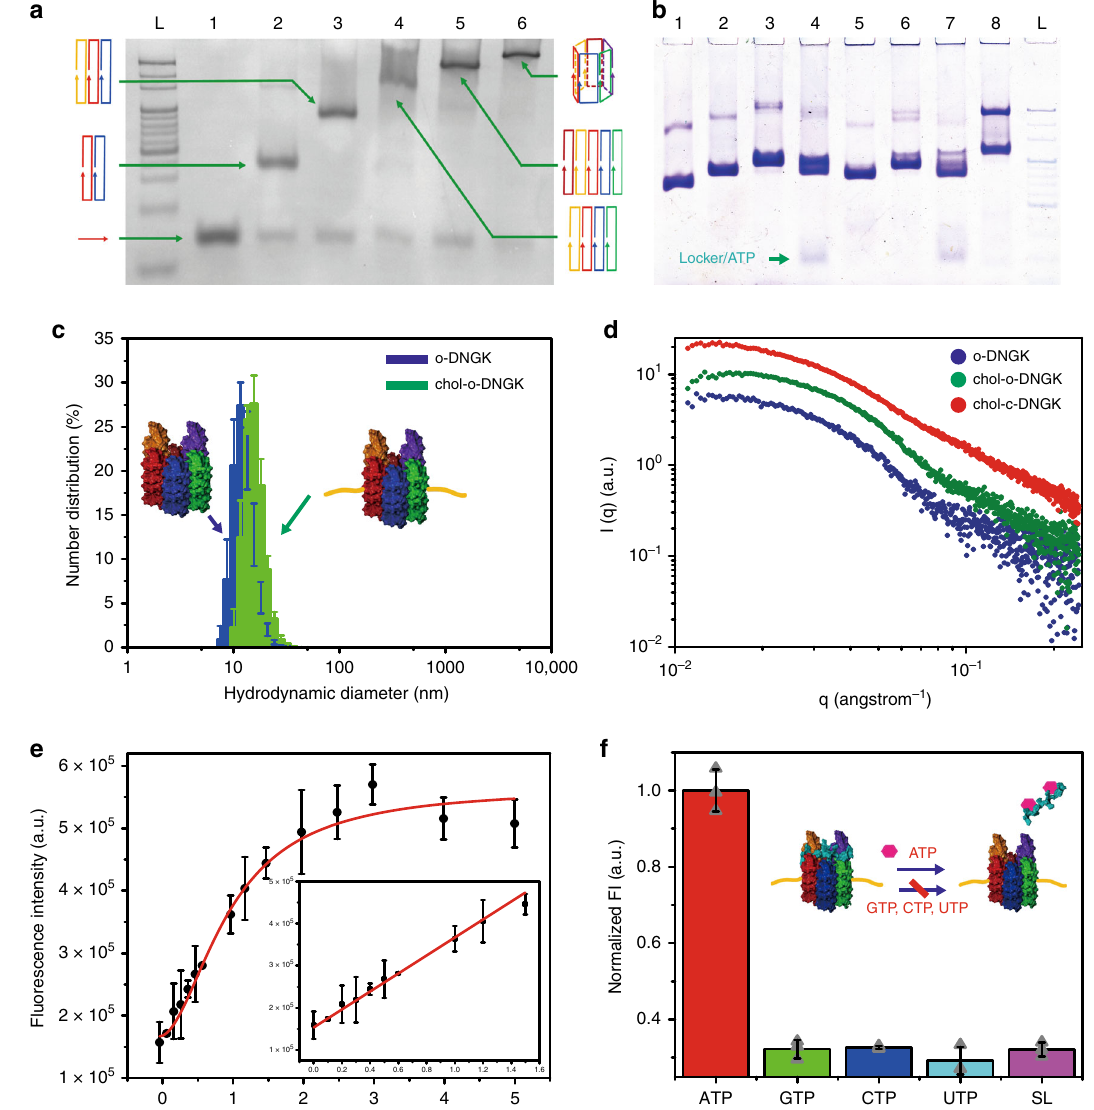
Fig. 2 One-pot DNA nanogatekeeper assembly in solution and ATP response. a PAGE analysis of stepwise assembly of DNA nanochannel. The bands of DNA nanochannel (lane 6) and assemblies of one to fi ve different component strands (Lanes 1 – 5, respectively) are shown with high yield. L: 20 bp ladder. b Five percent PAGE analysis of ATP response of chol-DNGK. Lane 1: DNA nanochannel; lane 2: o-DNGK; lane 3: c-DNGK; lane 4: c-DNGK with addition of 3 mM ATP; Lane 5: chol-o-DNGK; Lane 6: chol-c-DNGK; Lane 7: chol-c-DNGK with addition of 3 mM ATP; Lane 8: blocker version DNGK with a blocker. Lane L: 20 bp DNA ladder. c Dynamic light scattering (DLS) veri fi ed the size changes between nanogatekeeper and chol-DNGK. Error bars show